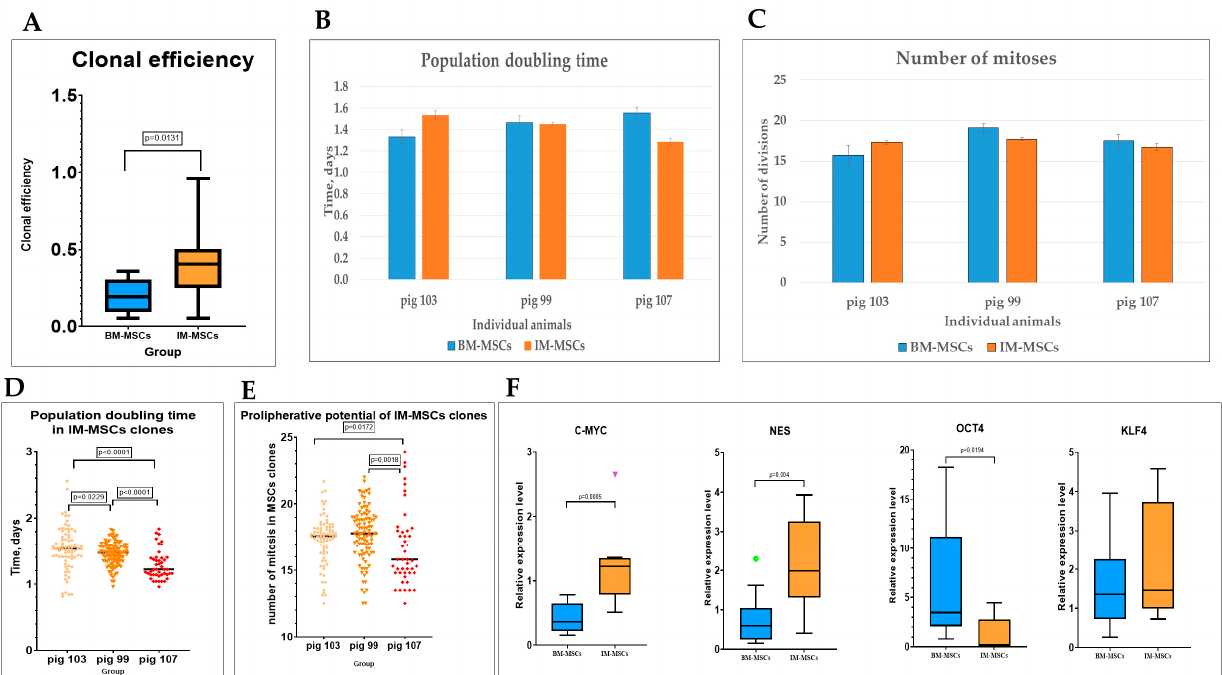
Figure 4. Characteristics of IM-MSCs. ( A ) Comparison of clonal efficiency of BM-MSCs and IM-MSCs. BM-MSCs and IM-MSCs were cloned 1 cell per well of the 96-well plate. Cloning efficiency was determined by the Poisson formula. ( B ) Population doubling time of BM-MSCs and IM-MSCs. ( C ) The number of performed mitoses. Variability of individual clones from different pigs. ( D ) Range of population doubling time in IM-MSCs clones from different mini pigs. ( E ) Individual differences in the proliferative potential of IM-MSCs clones from different mini pigs. ( F ) Comparison of C-MYC, NES, KLF4 and OCT4 relative gene expression in BM-MSCs and IM-MSCs. Data are presented as Turkey style box plots ( A , F ), scatter plots ( D , E ) and bar graphs ( B , C ). Green circle and purple triangle indicate outliers in corresponding groups.